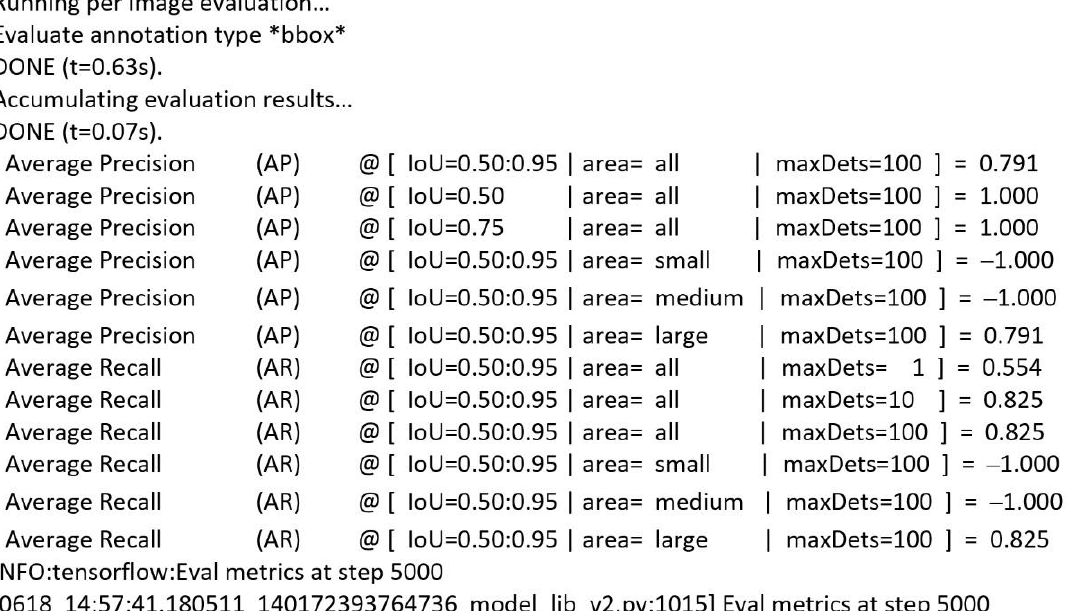
Figure 20. EfficientDet training results.